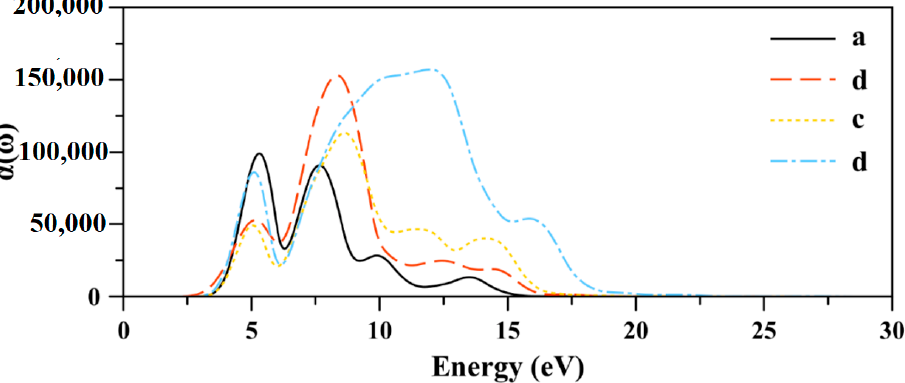
Figure 7. Variation in absorption as function of energy of ( a ) (NH 3 (CH 2 ) 2 C 6 H 5 ) 2 [SnCl 6 ], ( b ) Figure 7. Variationinabsorptionasfunctionofenergyof( a )(NH 3 (CH 2 ) 2 C 6 H 5 ) 2 [SnCl 6 ],( b )(C 6 H 10 N 2 )[SnCl 6 ], (C 6 H 10 N 2 )[SnCl 6 ], ( c ) (C 9 H 14 N) 2 [SnCl 6 ], and ( d ) (C 8 H 12 N) 2 [SnCl 6 ]. ( c ) (C 9 H 14 N) 2 [SnCl 6 ], and ( d ) (C 8 H 12 N) 2 [SnCl 6